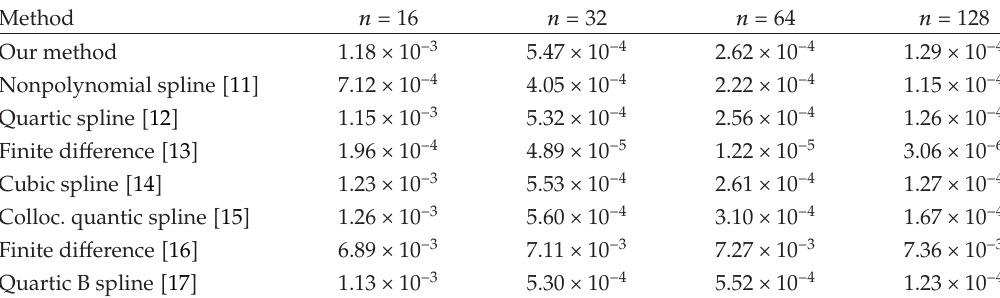
Table 4: The observed maximum errors of Example 3.2.